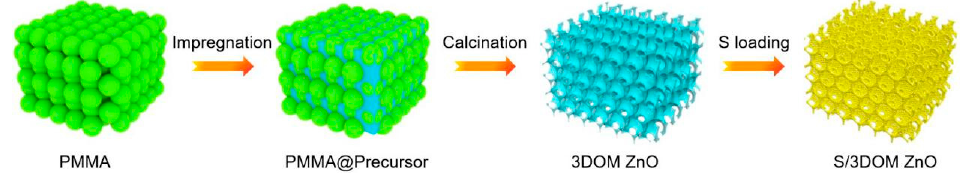
Figure 1. Schematic illustration of the synthesis process of sulfur added to the three-dimensionally ordered macroporous ZnO (S/3DOM ZnO).